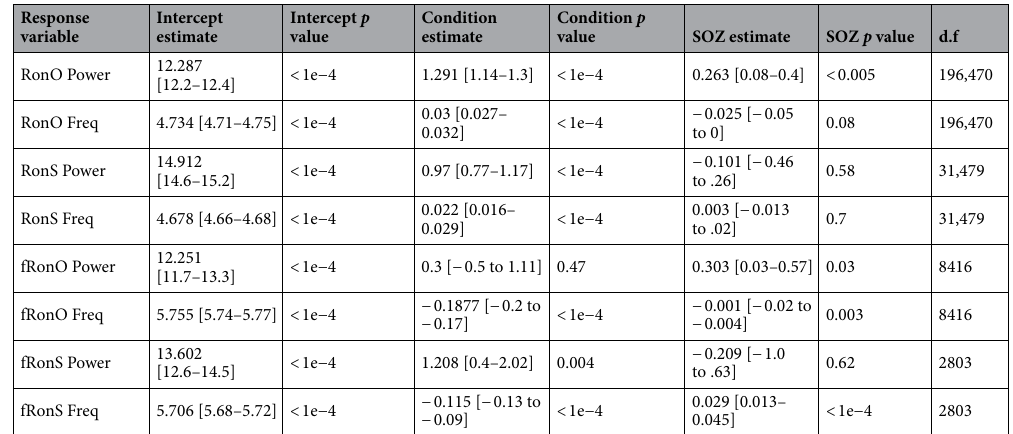
Table 1. Results of generalized linear mixed-effects models fitting HFO frequency and power. The random- effect term was electrode, the fixed effects were recording condition (intraoperative vs. non-REM sleep), and SOZ. Brackets indicate 95% confidence